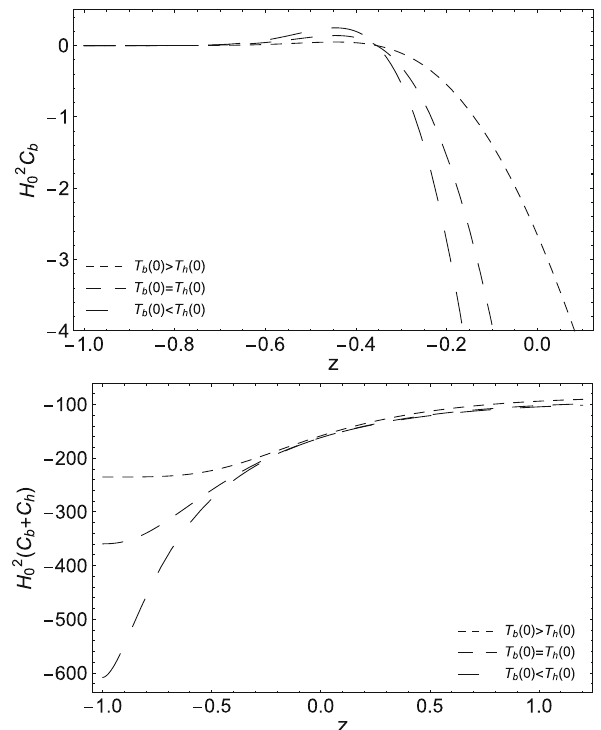
Fig. 5 DeformedGBmodel:weshowtheevolutionoftheheatcapacity of the bulk (upper graph) and the behaviour of the sum of capacities of the bulk and the horizon (lower graph). Also, as in the case of GB model, from criteria 1 and 2 exposed in Sect. 3, we observe that the thermal equilibrium is possible as a transient phenomenon